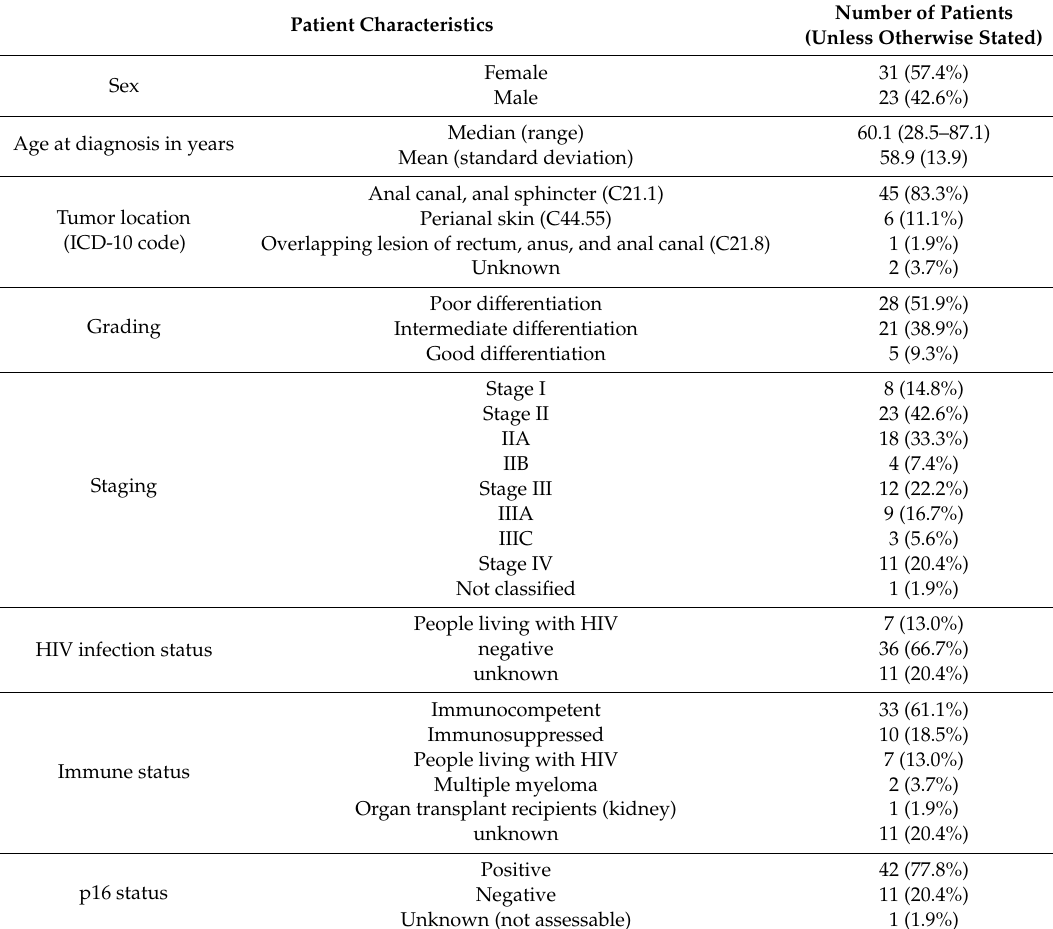
Table 1. Baseline characteristics of the study